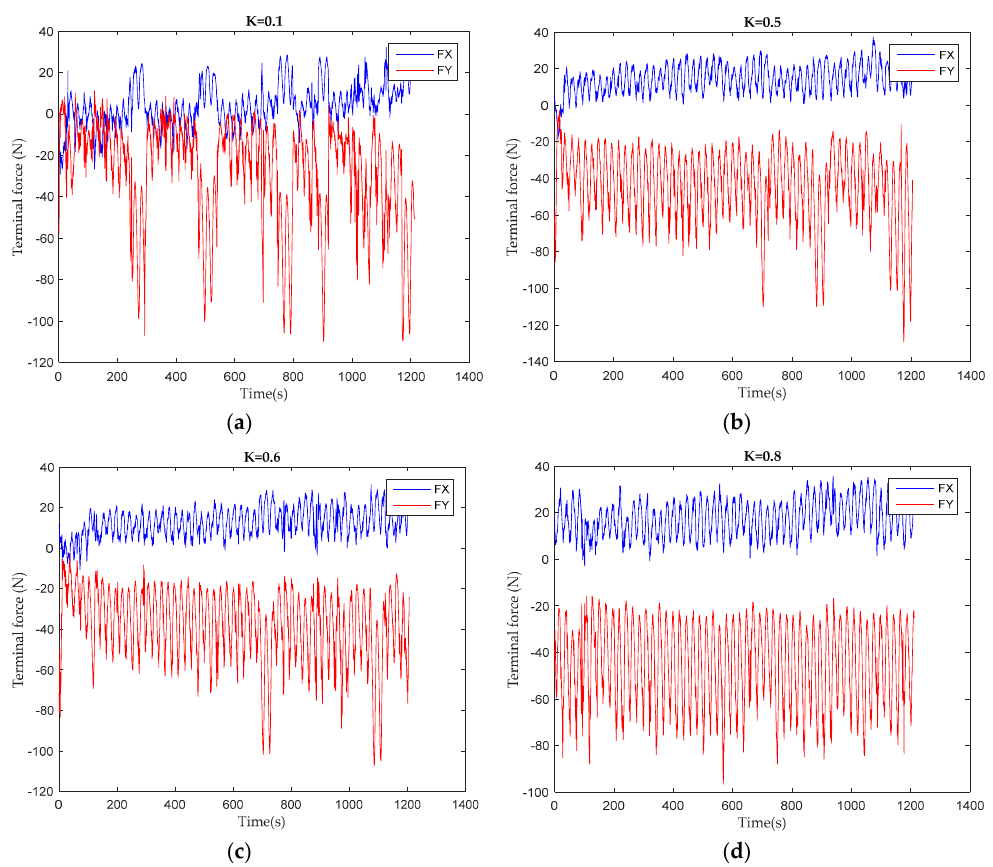
Figure 9. Terminal force during di ff erent di ffi culty tasks training: ( a ) the training task of assistant force parameter K = 0.1; ( b ) the training task of assistant force parameter K = 0.5; ( c ) the training task of assistant force parameter K = 0.6; ( d ) the training task of assistant force parameter K =